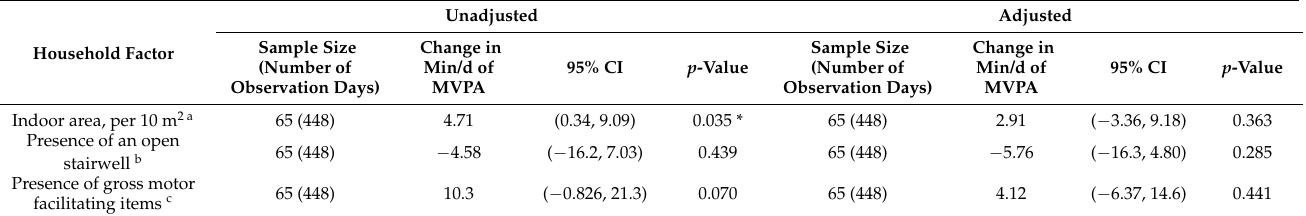
Table 3. Associations between household factors and average minutes of moderate to vigorous physical activity (MVPA) per